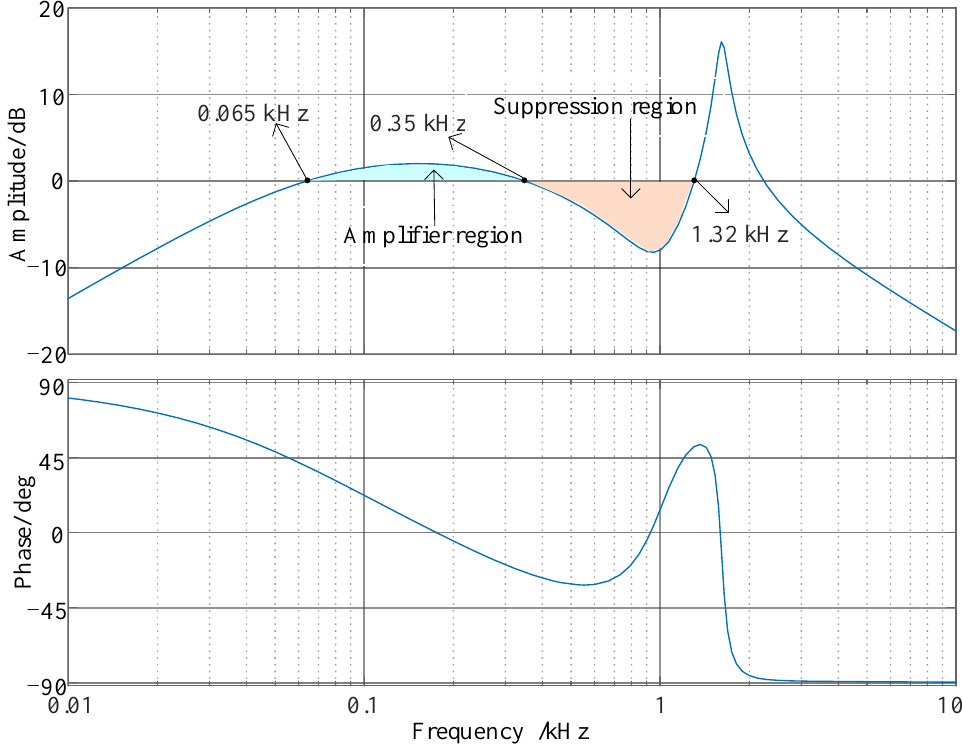
Figure 14. The bode plot of G u_i ( s ) with resonance controller under k r = 2.5 and ω n = 1002π rad/s .